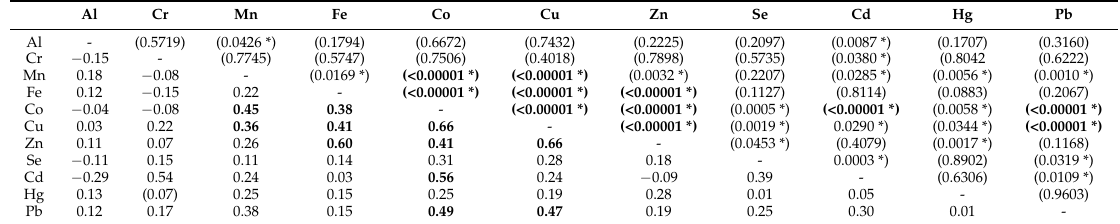
Table 2. Inter-metallic correlation coefficients (lower left-hand side) and p -values (in parentheses, upper right hand side) in fish liver samples at all four study sites over the three seasons. Significant correlations are highlighted with an asterisk (* p < 0.05) and in bold ( p <